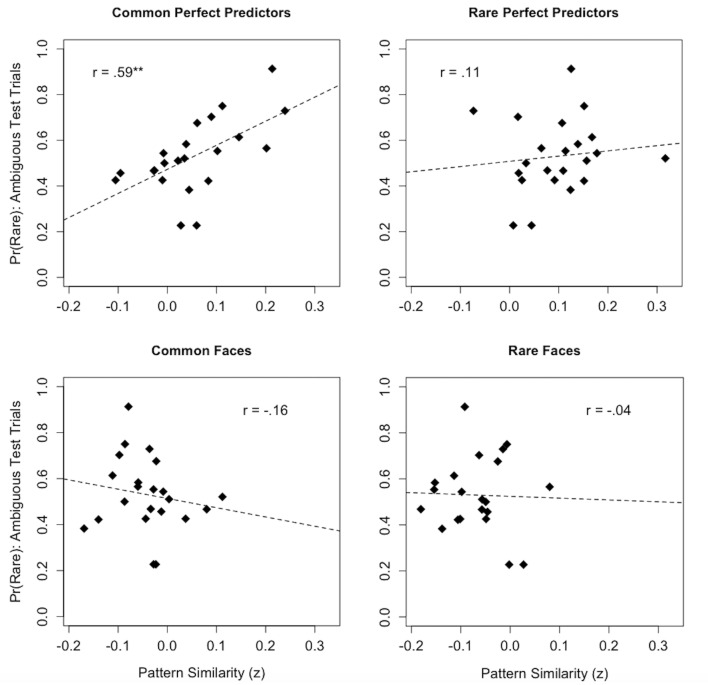
Associations between multivoxel pattern similarity to stimulus dimensions during the learning phase and individual differences in base rate neglect.For each graph, the y-axis depicts the proportion of rare responses made by each subject on ambiguous test trials, while the x-axis depicts subjects’ mean BOLD pattern similarity to a respective stimulus dimension over the course of learning. **p < 0.01.